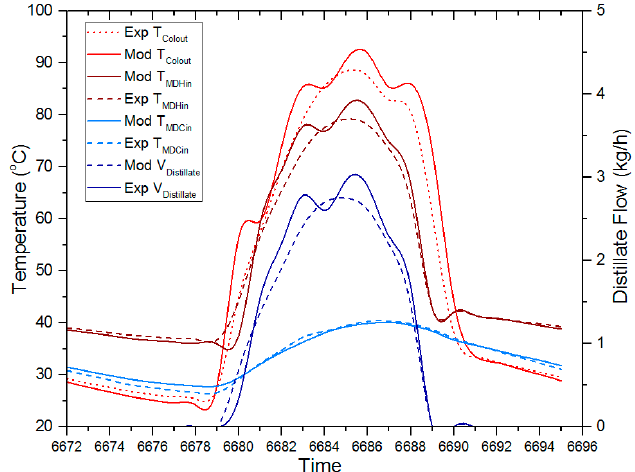
Figure 18. Temperature profiles and distillate flow in SCMD.